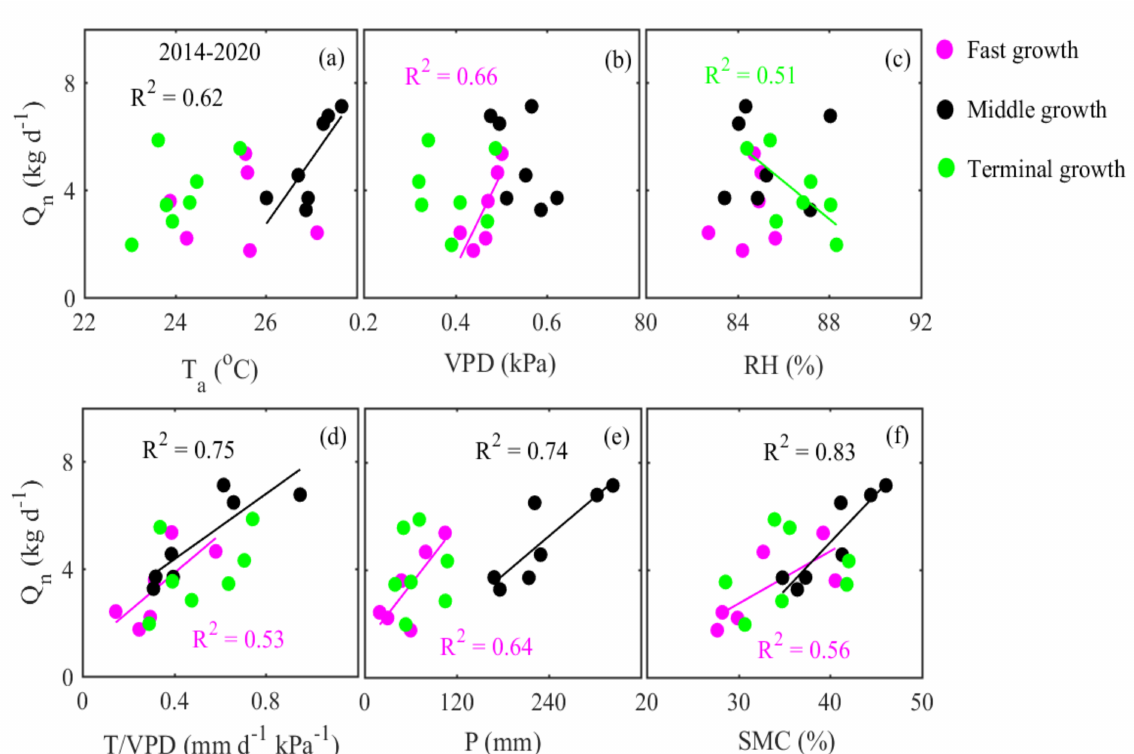
Figure 5. Mean nighttime sap flow (Q n ) at each of the three growing stages (i.e., fast growth, May; middle growth, June–August; and terminal growth, September–October) over 2014–2020 as a function of corresponding selected main explanatory micro-hydrometeorological parameters, including ( a ) air temperature (T a ), ( b ) vapor pressure deficit (VPD), ( c ) relative humidity (RH), ( d ) canopy conductance (T/VPD), ( e ) total nighttime precipitation (P), and ( f ) soil moisture content (SMC). The data points are the annual mean, with the exception of the annual total for P at each growing period, and the given solid lines are statistically significant ( p < 0.05). Note: (n = 6 for fast growth period, and n = 7 for middle and terminal growth